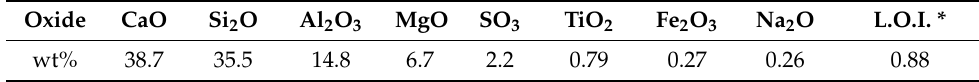
Table 1. Chemical composition of